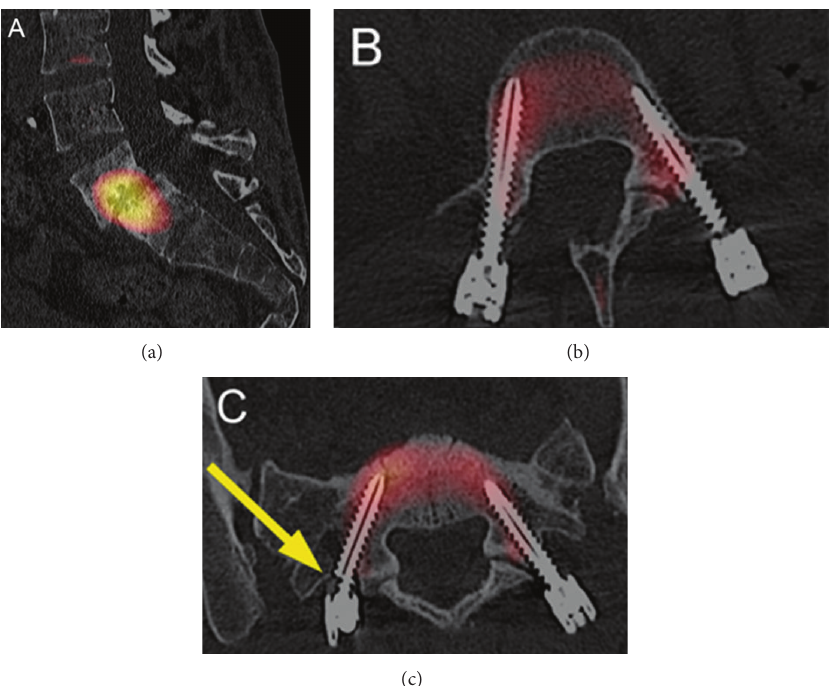
Figure 3: SPECT-CT revealed an intense uptake of the L5-S1 endplates (a) and a fracture of the right S1 screw without uptake and without bone resorption around the screw (c; arrow). The left S1 screw (c) and both L5 screws (b) showed no abnormalities, whereas the rods did.